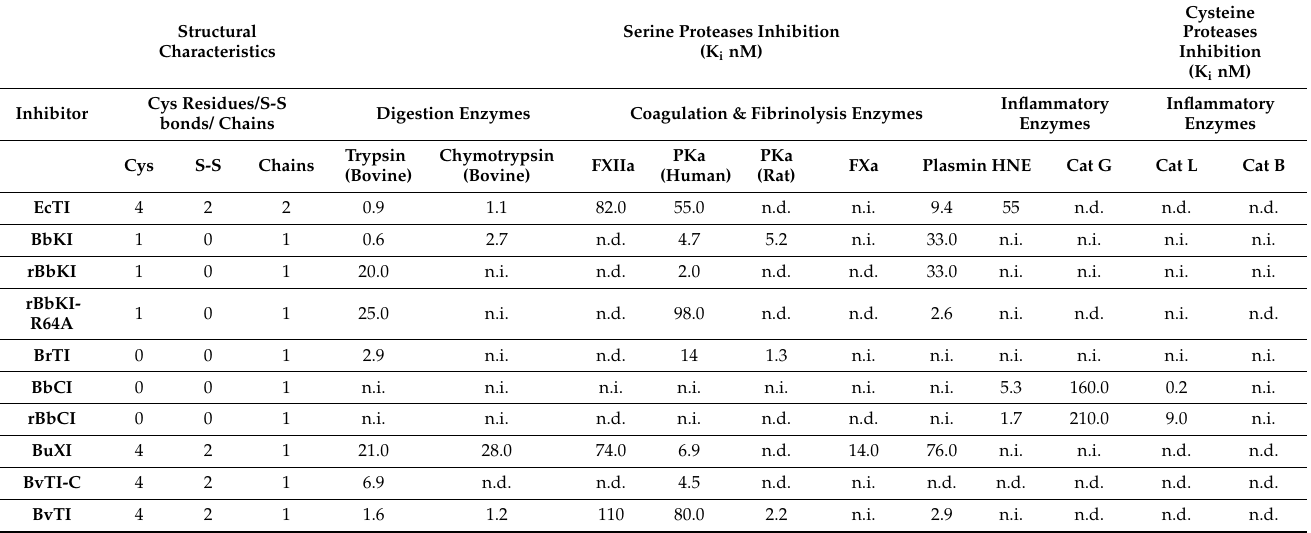
Table 1. Inhibitory Properties of some Plant Kunitz